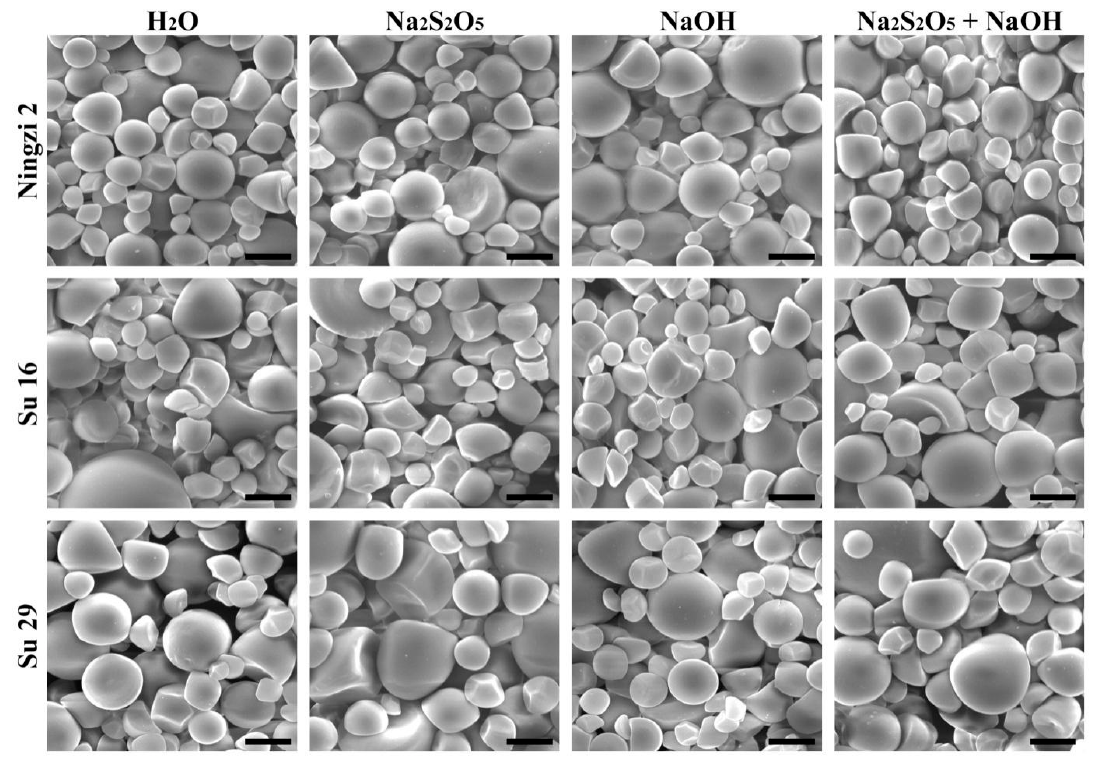
Figure 1. SEM photographs of starch granules. Scale bar = 10 μ m. Table 2. Granule size of starches.